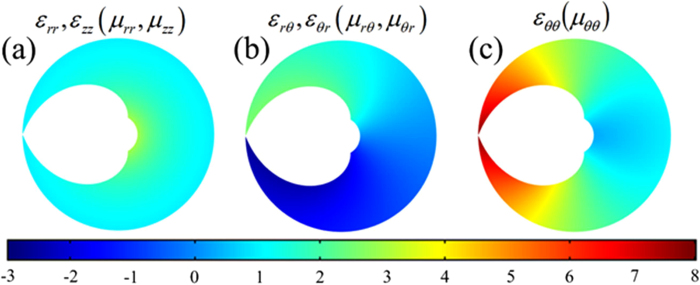
Permittivity and permeability distributions of PL with R0 = 1(m), r0 = 0.2(m), and τ = 1/6.